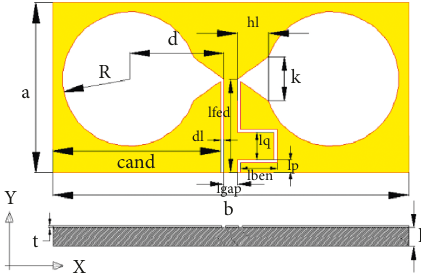
Figure 5: The geometry of antenna 3 with the ACPW.